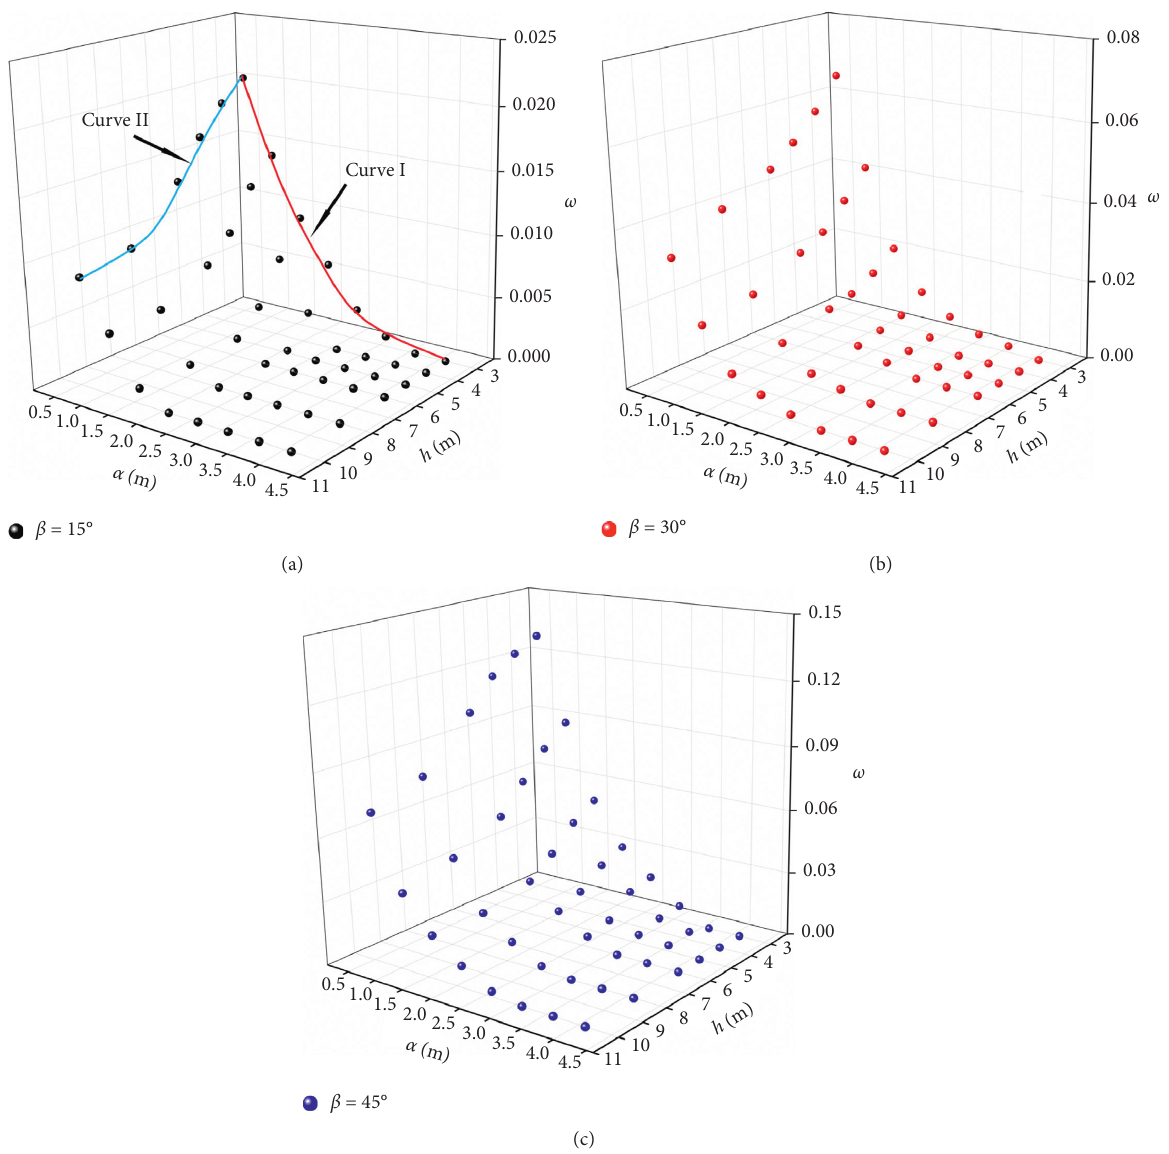
Figure 11: The 3D sketches of the attenuation coefficient ω with respect to distance a and embedment depth h with β of (a) 15 ° , (b) 30 ° , and (c) 45 °